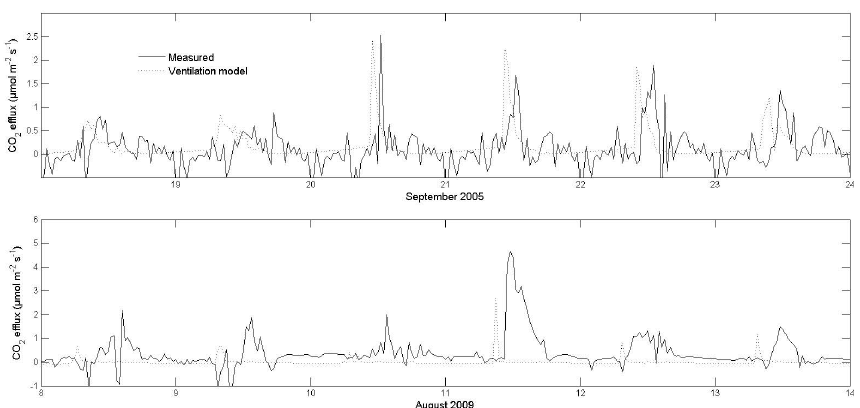
Fig. 3. Comparison of measured and modeled CO 2 efflux. Comparison the the time series of the ventilative CO 2 efflux as measured (black line) and modeled (dotted line). Two different periods are displayed, each of years with a very distinct dry